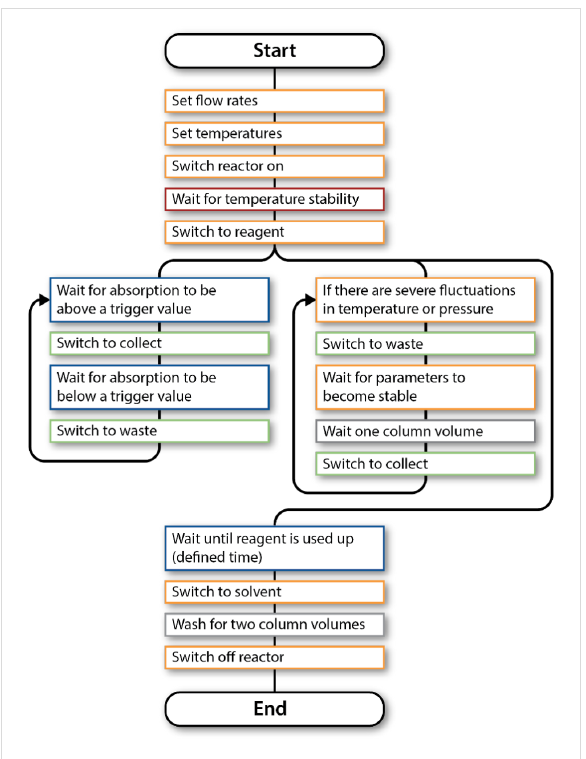
Figure 6: Flowchart describing the control sequence for operating and monitoring the hydration reaction. The black line indicates the execu- tion sequence from start to end. Branch points indicate parallel execu- tion. (See Supporting Information File 2 for the control